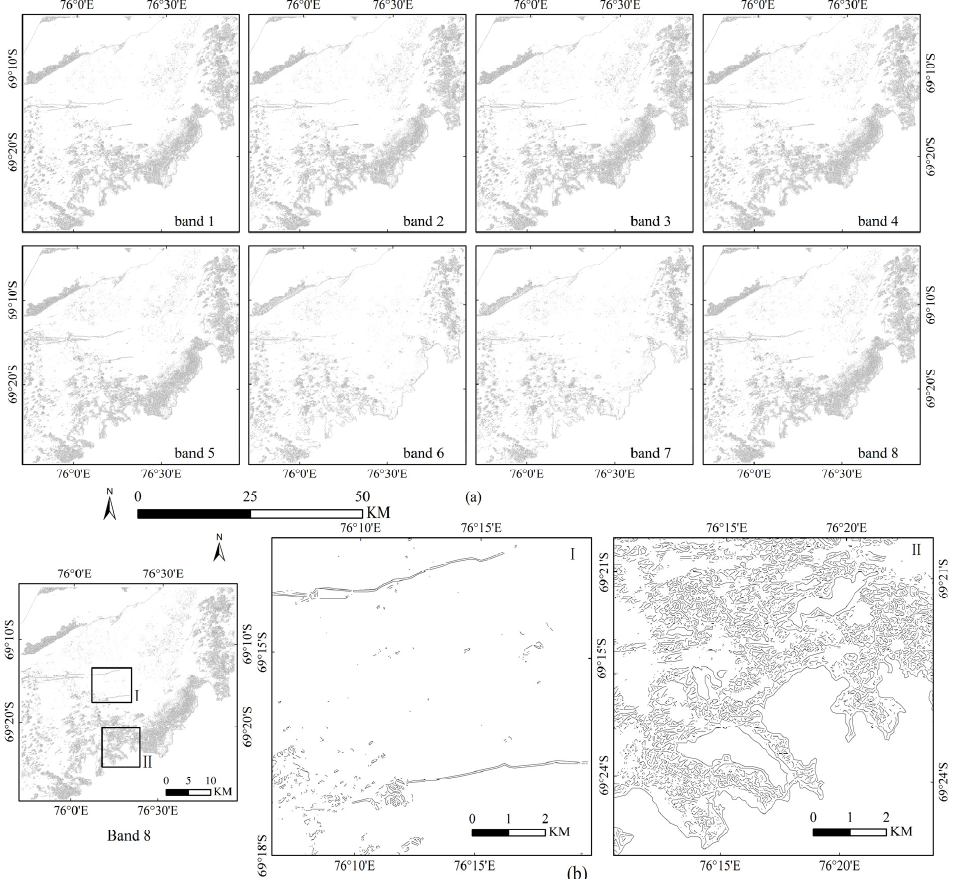
Figure 3. The line segments extracted by the LINE module in Bands 1-8 using the TOA reflectance data with 15-m resolution as input to the module. ( a ) Top two-row panels show line segments from using each band; and ( b ) the bottom panels are zoom-in sections of the line segments in Band 8. Table 2. Numbers of detected lines with different lengths using the TOA reflectance data with a resolution of 15 m.